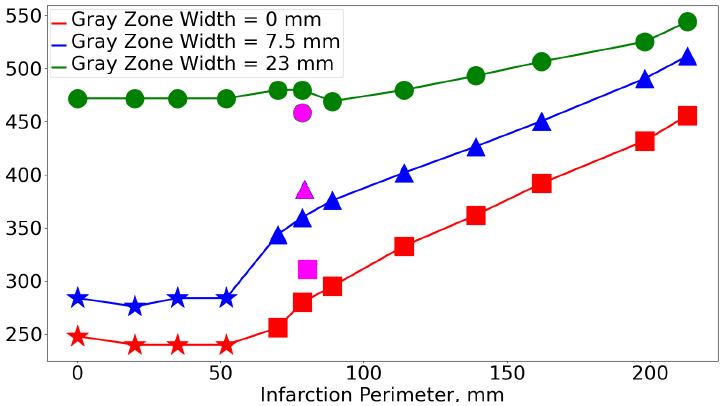
Figure 5. Dependence of the wave rotation period on the perimeter of the infarction scar at various gray zone width. A pink points indicate the results for realistic shape infarct. A star indicates functional rotation , a triangle indicates gray zone rotation , a square indicates scar rotation , and a circle indicates scar rotation two